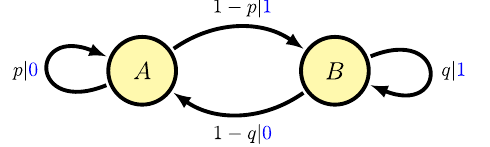
FIG. 5. ϵ -Machine generator of the Perturbed Coins Process. Edges are labeled with conditional transition probabilities and emitted symbols. For example, for the self-loop on state A , p j 0 indicates that the transition is taken with probability P ð 0 j A Þ ¼ p , and the symbol 0 is